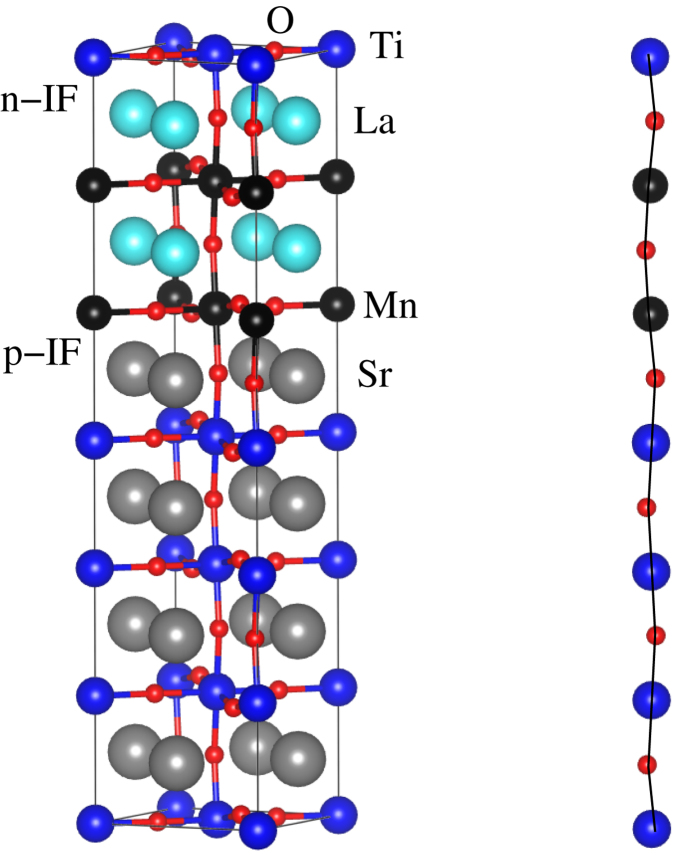
Left: Structure of the (LaMnO3)n/(SrTiO3)m superlattice for n:m = 2:4. Right: Schematic view of the Mn-O and Ti-O bonds perpendicular to the interfaces.